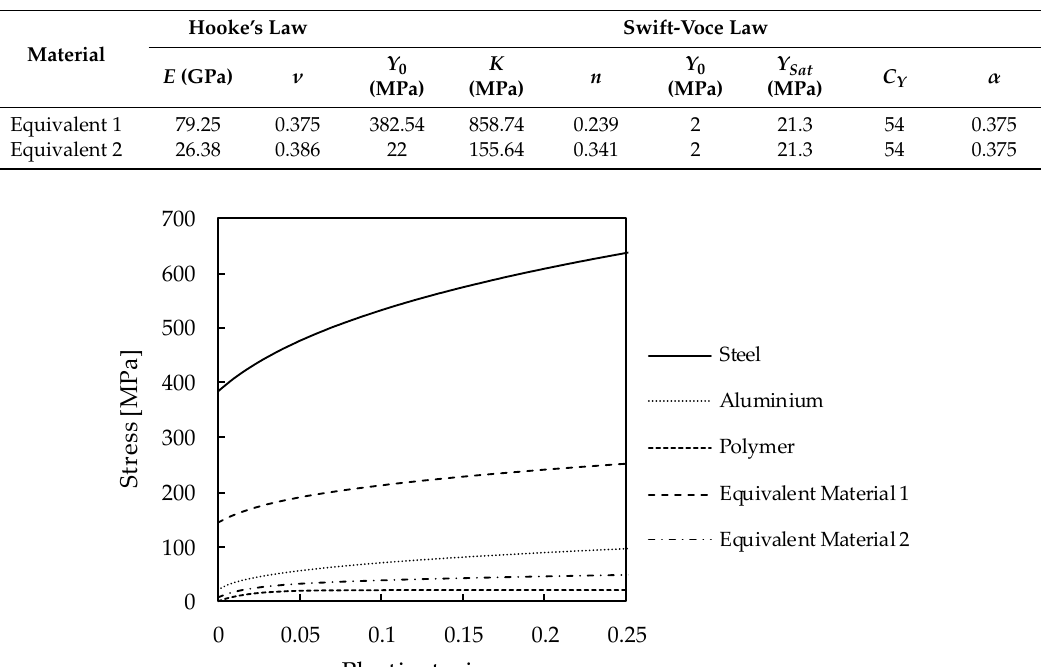
Table 4. Parameters describing the elastoplastic behaviour of the equivalent materials.